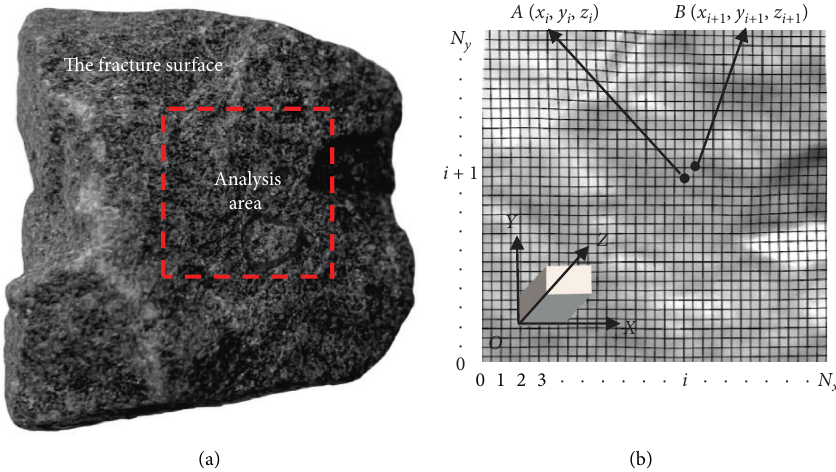
Figure 4: 3D contour surface of the aggregate. (a) Analysis area. (b) Contour surface point